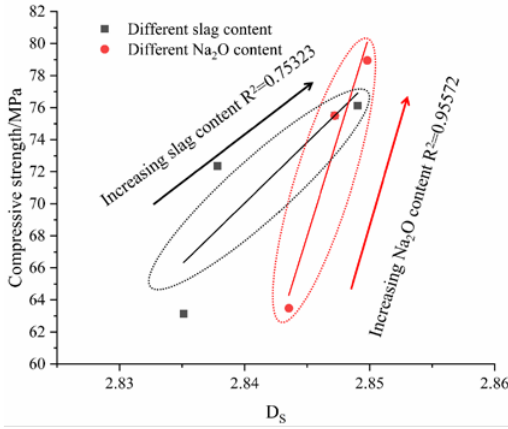
Figure 16. Relationship between the fractal dimension and compressive strength.